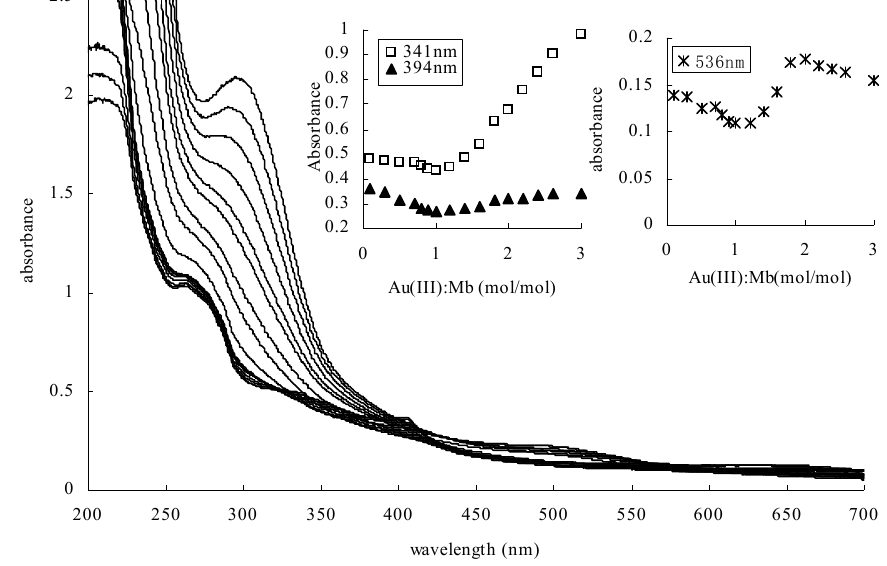
Figure 2. UV-visible absorption spectra of methanobactin (Mb) following the addition of Au